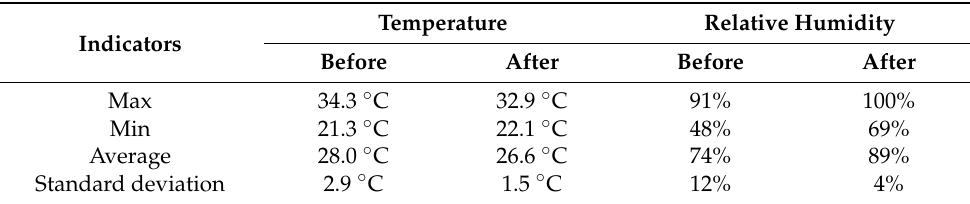
Table 7. Results of greenhouse environmental control on internal temperature and relative humidity before and after spraying for environmental cooling by the SMCS (20 May 2019–20 July 2019). Temperature Relative Humidity Indicators Before After Before